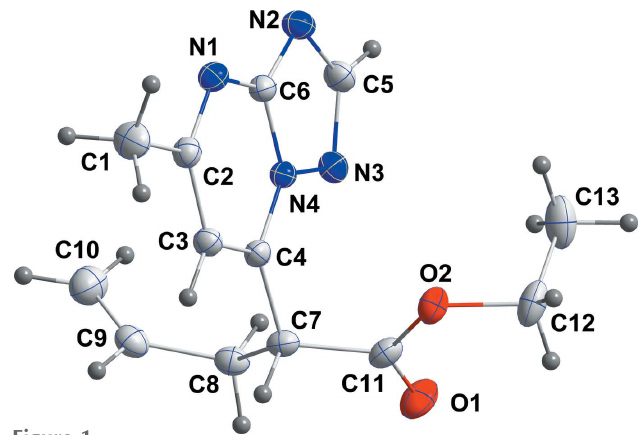
Figure 1 The title molecule with labelling scheme and 50% probability ellipsoids. For the sake of clarity, disorder of methyl group C1 is not